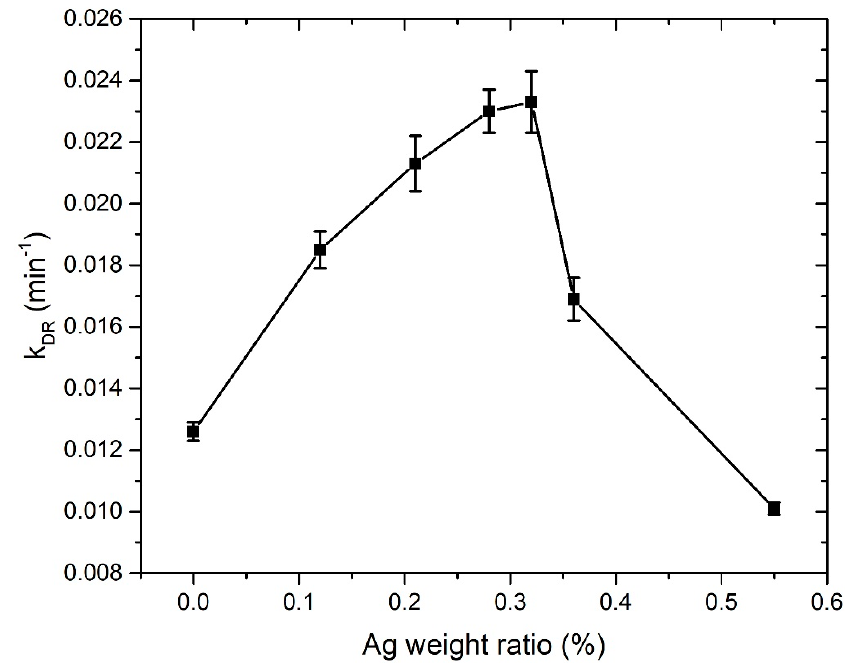
Figure 13. Photodegradation rate dependence on ICP-OES calculated Ag weight ratio in Ag-doped ZnO NPs .